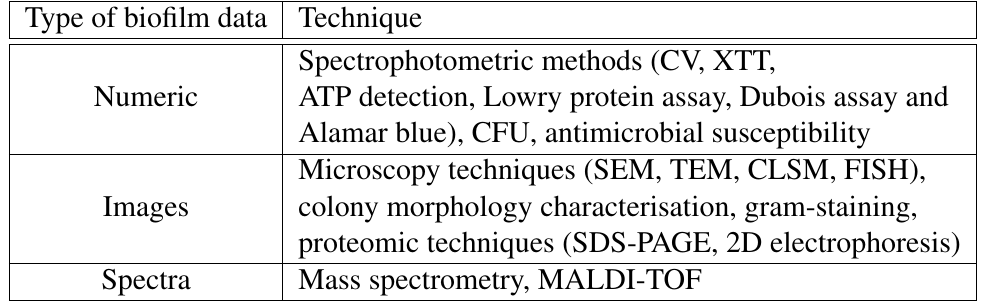
Table 1: Typical types of biofilm data and